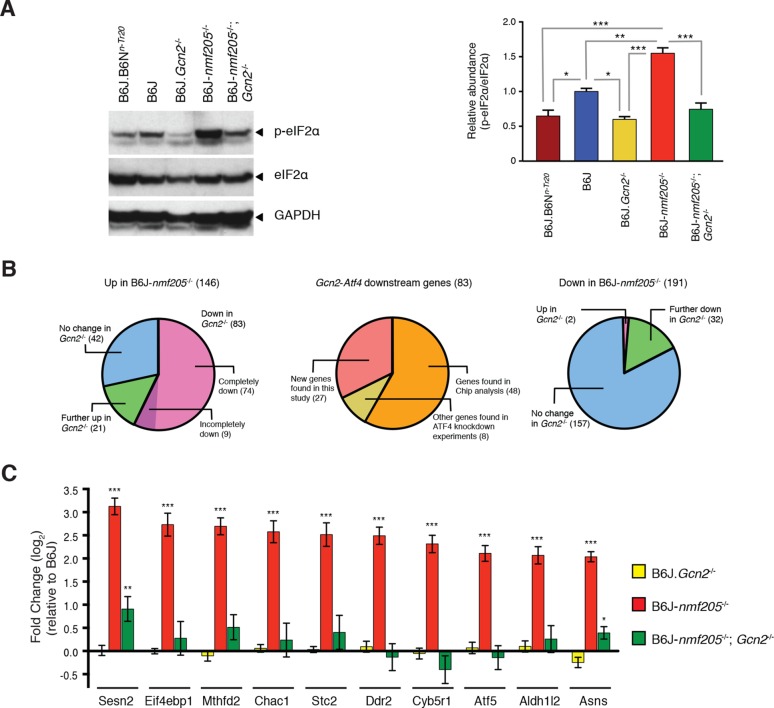
GCN2 mediates eIF2α phosphorylation and ATF4 activation in the B6J-Gtpbp2nmf205-/- brain.(A) Western blot analysis of cerebellar extracts from 3-week-old mice incubated with the antibodies shown (left panel). The relative abundance of phospho-eIF2α (Ser51) to total eIF2α was averaged for three biological replicates (right panel). Values are shown relative to B6J. (B) The effect of Gcn2 deletion on the 146 genes upregulated or the 191 genes downregulated by 1.5 fold (padj < 0.01) in the cerebellum of B6J-Gtpbp2nmf205-/- (B6J-nmf205-/-) relative to that of B6J (left and right diagram, respectively). ATF4 target status of the 83 genes that are upregulated in the B6J-Gtpbp2nmf205-/- cerebellum relative to B6J and that also have a significant decrease in expression in the B6J-Gtpbp2nmf205-/-; Gcn2-/- cerebellum relative to B6J- Gtpbp2nmf205-/- (middle diagram). (C) Fold change of upregulated ATF4 downstream genes from B6J-Gcn2-/-, B6J-Gtpbp2nmf205-/-, and B6J-Gtpbp2nmf205-/-; Gcn2-/-mice relative to B6J expression. The 10 most upregulated genes in cerebellum of B6J-Gtpbp2nmf205-/-mice relative to that B6J are shown. Note that the increased expression of these GCN2-ATF4 downstream genes in the B6J-Gtpbp2nmf205-/- cerebellum was completely suppressed by deletion of Gcn2. Error bars = SEM. *p<0.05, **p<0.01, and ***p<0.001 (one-way ANOVA, A, C).DOI:
http://dx.doi.org/10.7554/eLife.14295.01410.7554/eLife.14295.015Figure 3—source data 1.GCN2 RNA-Seq.DOI:
http://dx.doi.org/10.7554/eLife.14295.01510.7554/eLife.14295.016Figure 3—source data 2.GCN2-regulated ATF4 target genes.DOI:
http://dx.doi.org/10.7554/eLife.14295.01610.7554/eLife.14295.017Figure 3—source data 3.GCN2 RNA-Seq GO & KEGG analysis.